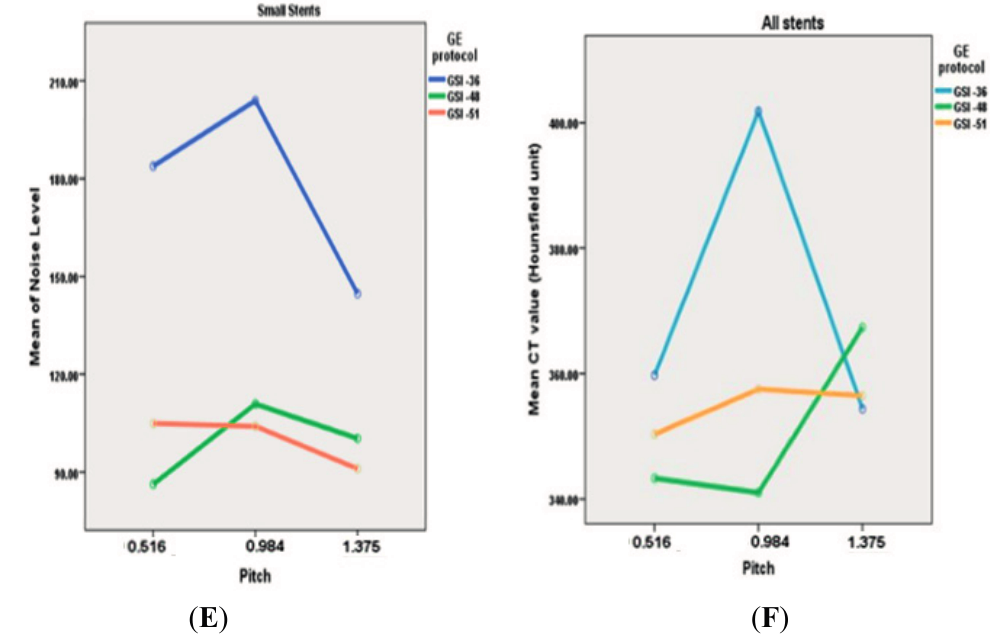
Figure 3. ( A – E ) A comparison of relationship between noise levels measured with different GSI protocols and pitch values at 65 keV with different diameters of stents; ( F ) represents the mean of CT values measured in all stents with use of three GSI and pitch